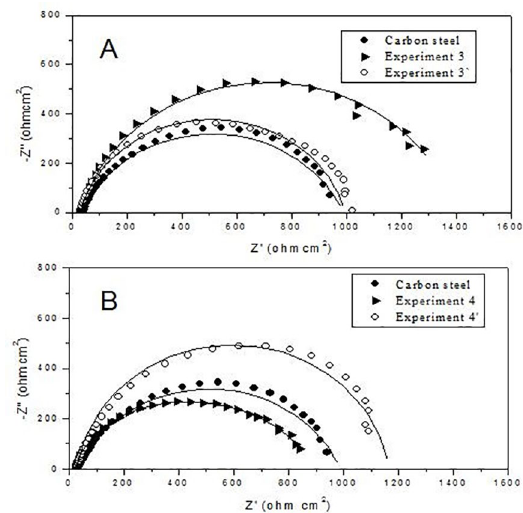
Figure 6. Nyquist diagrams for Co-rich Cu-Co coating/carbon steel substrates in NaCl 0.5 mol L -1 under the conditions of (A) Experiments 3 and 3’ (j = jm = 15 A m -2 , using DC and SPC, respectively) and (B) Experiments 4 and 4’ (j = jm = 40 A m -2 , using DC and SPC, respectively)